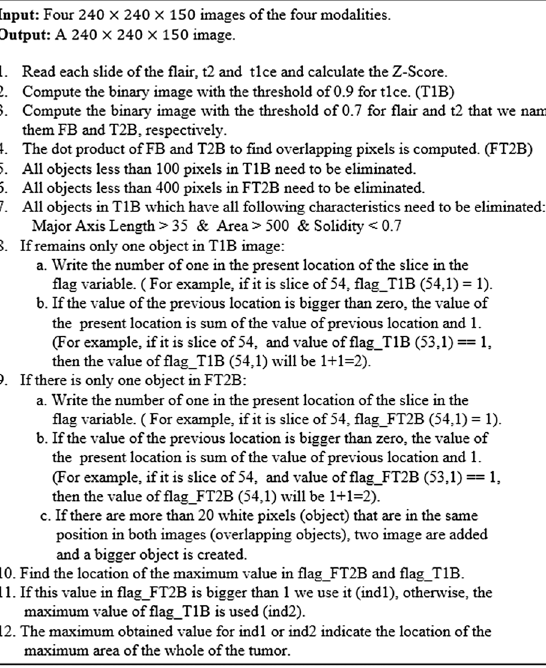
Figure 6. Pseudocode of the proposed algorithm for detecting the biggest tumor among all